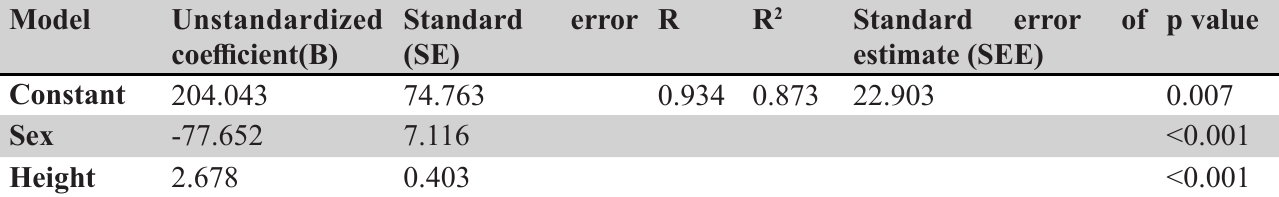
Table 3: Stepwise regression analysis of predictors of 6MWD in combined participants.